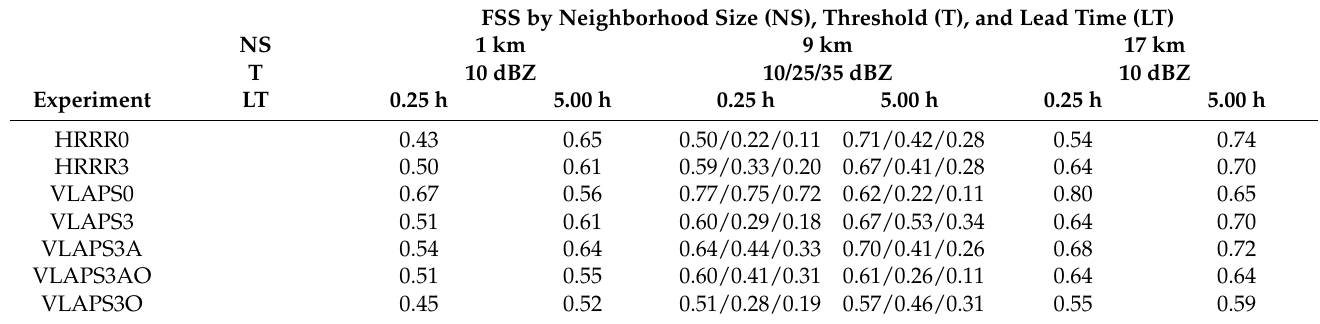
Table 6. FSS as it varies across three different neighborhood sizes for the 10 dBZ threshold, and for two different lead forecast times (near the start and end of the forecast period). Note that additional thresholds of 25 dBZ and 35 dBZ are shown only for the 9 km neighborhood size (since 9 km is of interest due to it closely representing the effective resolution of the WRF output produced from the 1 km grid spacing